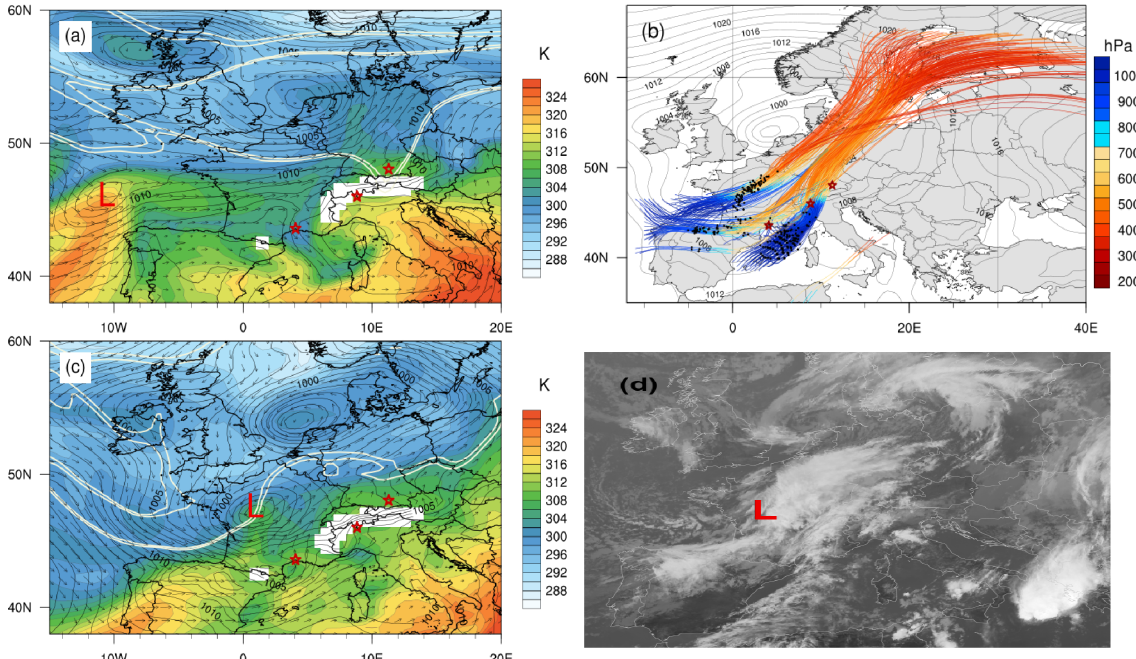
Figure 2. Synoptic development during the T-NAWDEX-Falcon IOP2: (a) EDA mean equivalent potential temperature at 850hPa (colours, K), sea level pressure (SLP, black contours every 1hPa), wind arrows at 850hPa (black) and PV at 315K (white line of 1.5 and 2PVU) at 18:00UTC on 13 October 2012. Red asterisks mark the measurement stations of the HyMeX lidar, the Monte Lema radar and the airbase of Falcon. (b) WCB trajectories of the EDA’s CTL starting at 00:00UTC on 14 October 2012 (coloured by pressure, hPa) and SLP (black lines every 2hPa valid at 12:00UTC on 14 October), with trajectory markers (black dots) for 12:00UTC on 14 October. Panel (c) shows the same as panel (a) but for 12:00UTC on 14 October. (d) Meteosat infrared image at 12:00UTC on 14 October. The red “ L ” in panels (a) , (c) and (d) marks the location of the surface